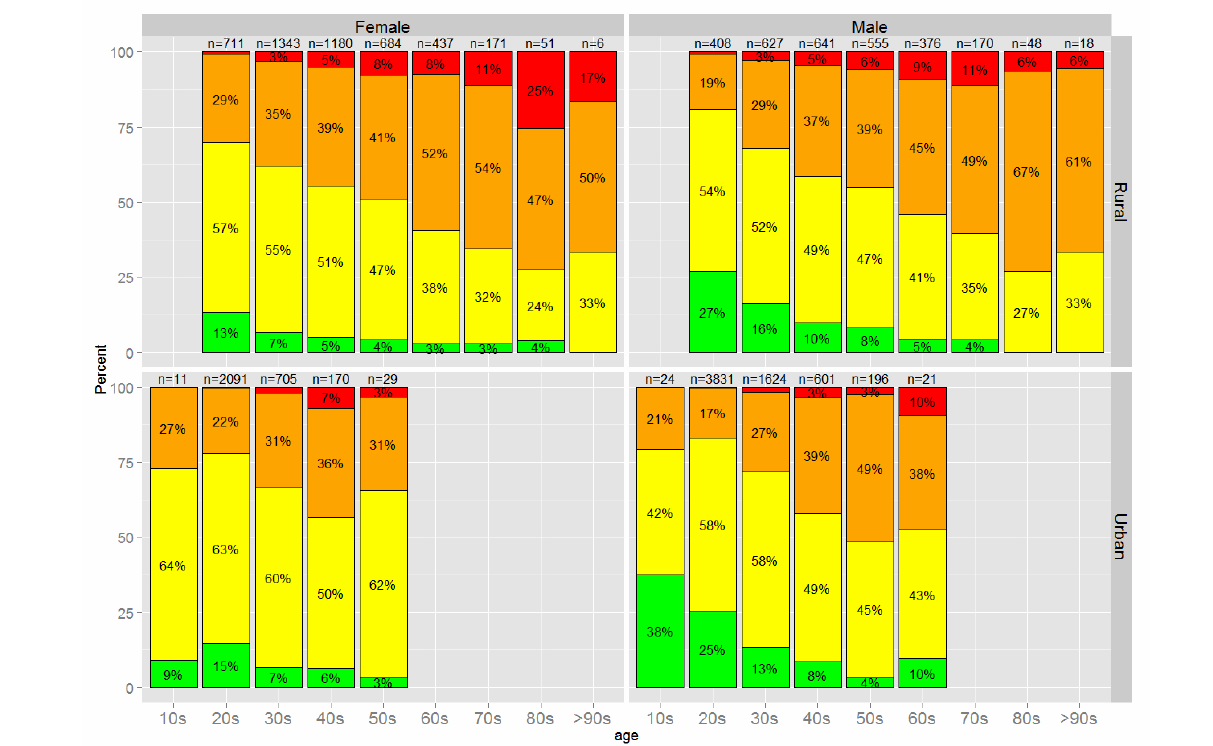
Figure 6. Overall results by age, sex, and area (subject numbers are shown above the